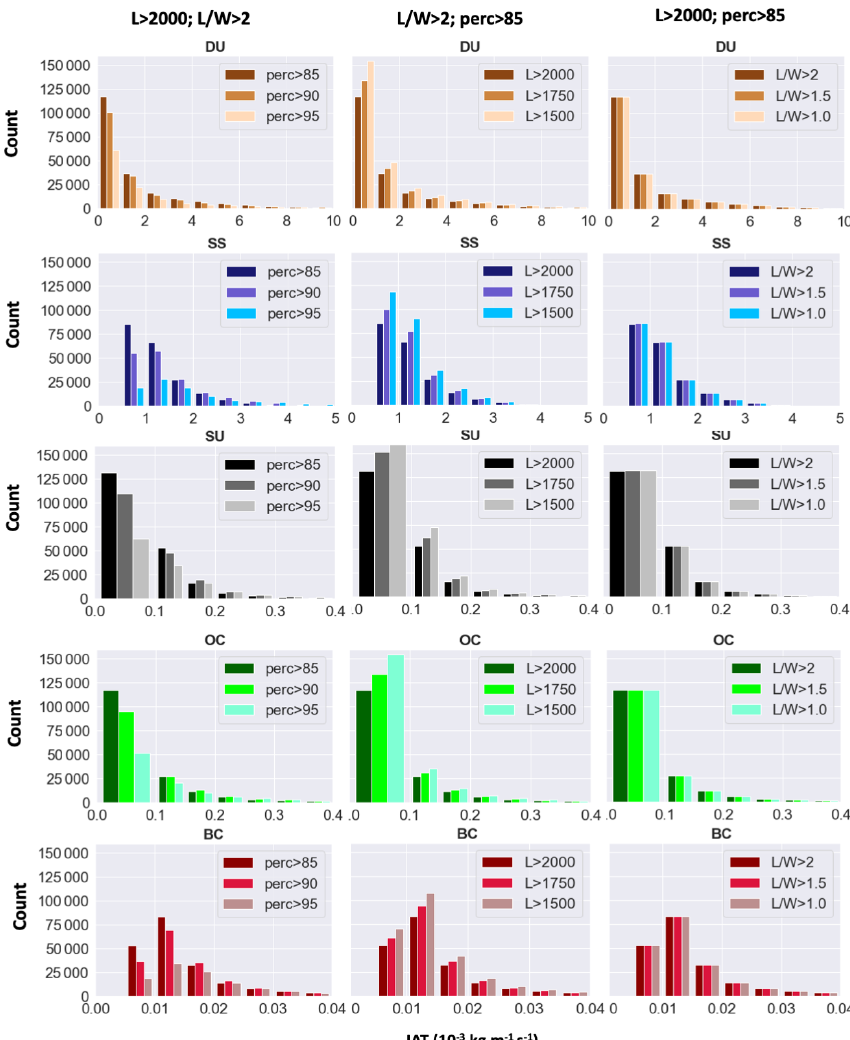
Figure 9. Sensitivity of AAR detection to threshold values used for three key parameters (corresponding to the three columns; see the legend for the parameter being tested and the three values chosen for each test parameter) in the detection algorithm for five aerosol species (corresponding to the five rows; see the panel title for the aerosol species). Shown are histograms of mean IAT of individual AARs detected. For example, the left column shows results based on perturbing the IAT percentile threshold (85th, 90th, and 95th percentiles), while keeping the length (2000km) and aspect ratio (2) thresholds unchanged from the main analysis presented